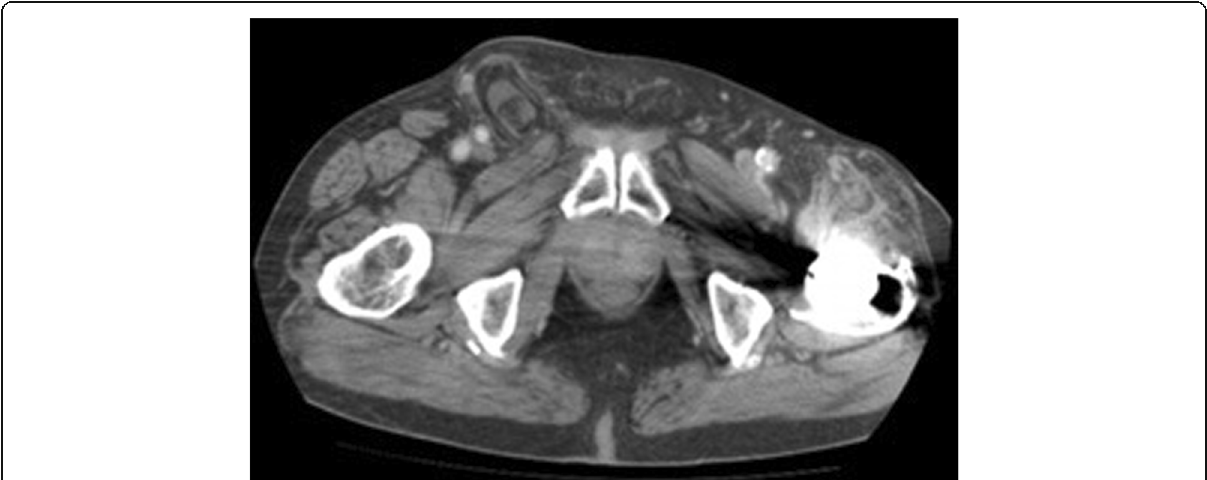
Fig. 2 Computed tomography anterior-posterior view of described Amyand